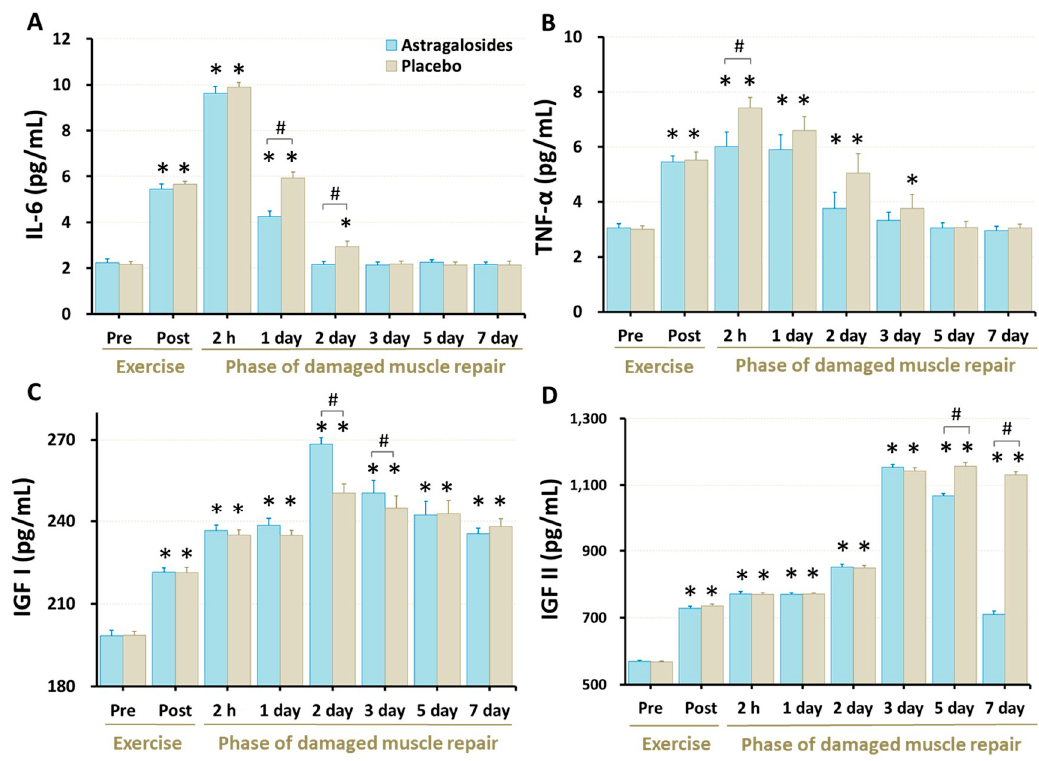
Figure 3. Effect of astragalosides supplementation on serum levels of ( A ) interleukin-6 (IL-6), ( B ) tumor necrosis factor-alpha (TNF- α ), ( C ) insulin-like growth factor I (IGF-I), and ( D ) insulin-like growth factor II (IGF-II). The levels of IL-6, TNF- α , IGF-I, and IGF-II were measured before and after eccentric exercise, and at 2 h, 1, 2, 3, 5, and 7 days of the recovery period. Values are expressed as means ± SD ( n =11). * p < 0.05 vs. pre-exercise for the same group. # p < 0.05 vs. placebo for the same time.